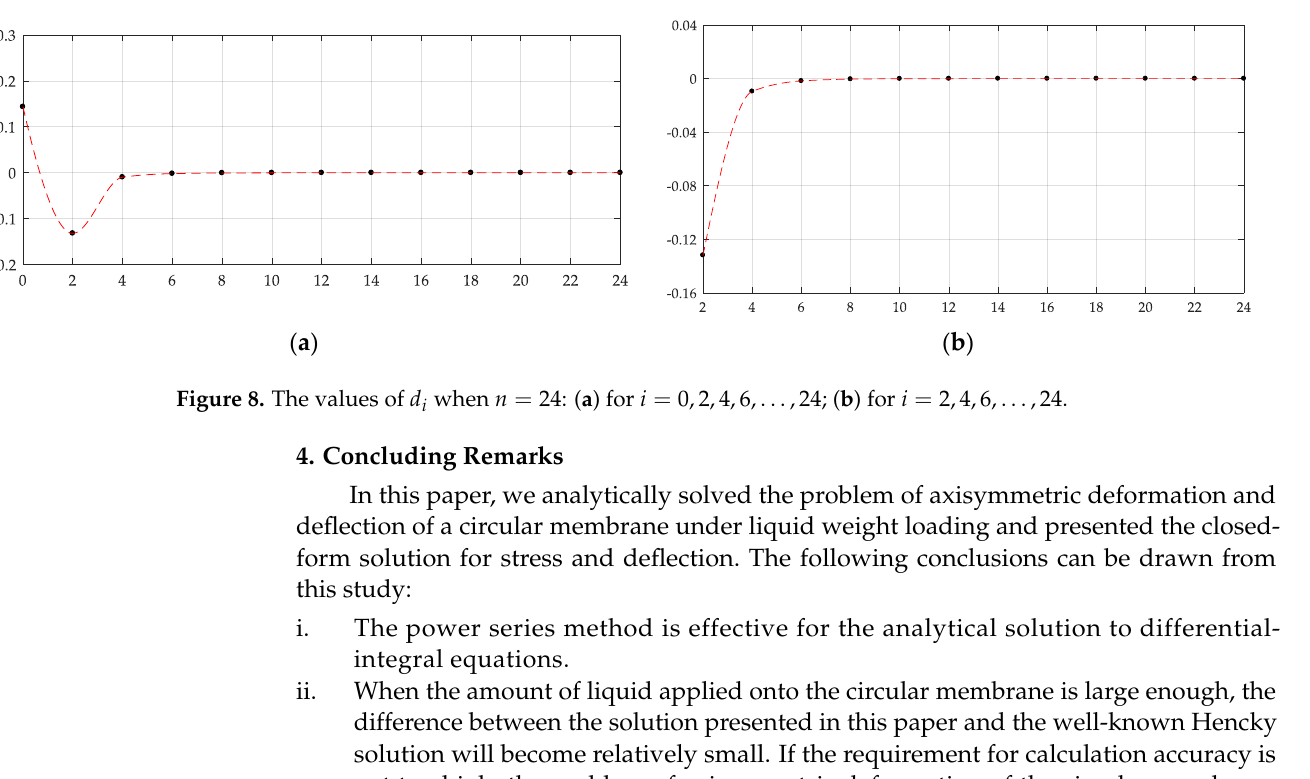
Figure 7. The values of c i when n = 24: ( a ) for i = 0,2,4,6, . . . ,24; ( b ) for i = 2,4,6, . . . ,24.